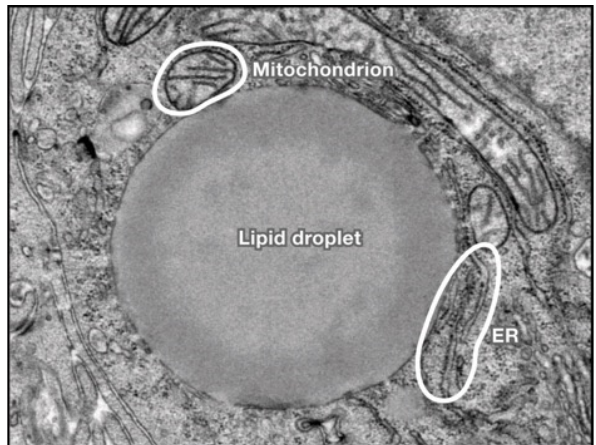
Figure 2. Transmission electron microscopy (TEM) of a hepatocyte from a liver biopsy of an ALD patient. A huge lipid droplet covers the surface of the cell. Endoplasmic reticulum (ER) can be seen. In the upper corner, a mitochondrion with irregular cristae is seen. ×37,500. Unpublished picture adapted from our study- Cameron RG and Neuman MG [157].